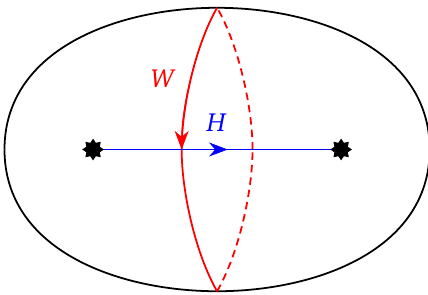
Figure 13: The Type IIA brane construction associated to 6d A pactified on a sphere with 2 irregular punctures of type P